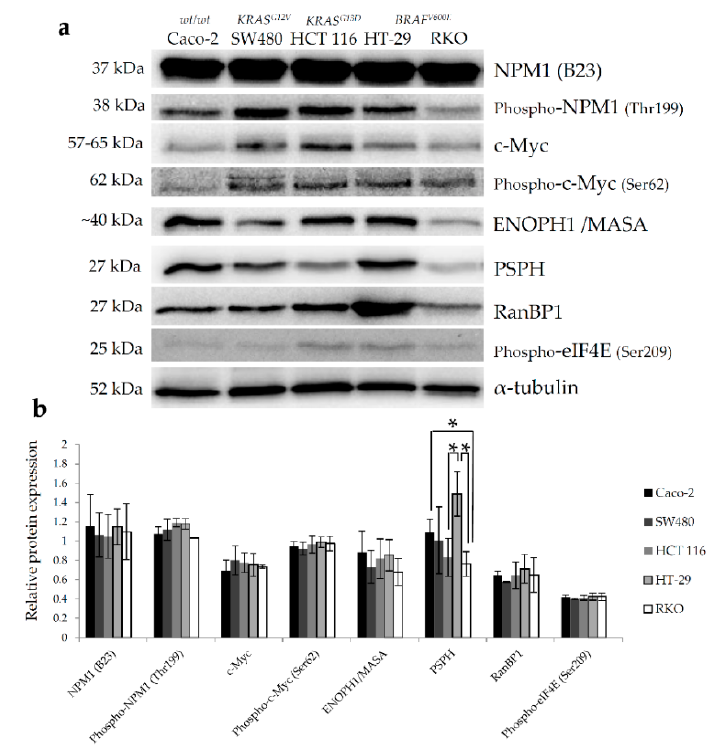
Figure 3. Western blot analysis of baseline levels of protein candidates chosen from proteomic dataset of up-regulated proteins in BRAFV600E mutant colon cancer cells following bioinformatics analyses. ( a ) Representative western blot images showing the baseline expression levels of selected proteins in two BRAFV600E mutant colon cancer cell lines harboring WT KRAS (HT-29 and RKO), two WT BRAF cell lines carrying KRAS mutations (HCT 116 and SW480) and a double WT colon cancer cell line (Caco-2). α -Tubulin was used as loading control. ( b ) Relative protein expression of selected proteins measured by densitometry analysis of individual bands using Quantity One software. Data represent mean and standard deviation obtained from three independent biological experiments. α -Tubulin was used as loading control. Statistical significance where p < 0.05 is denoted with an asterisk.